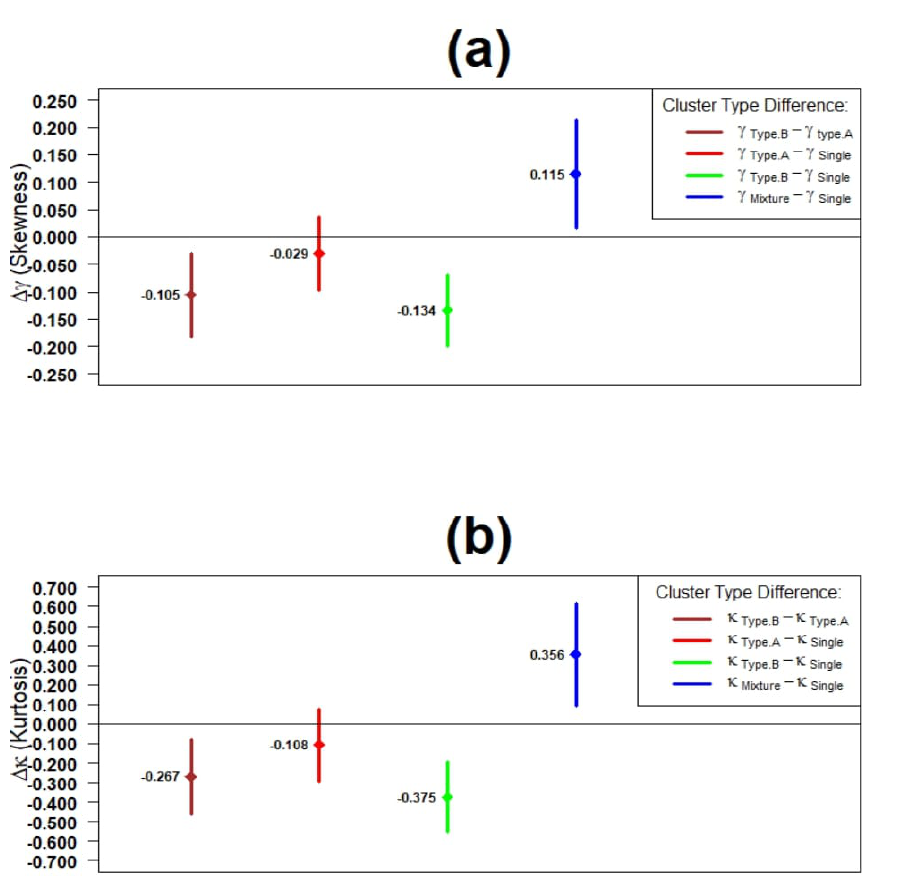
Figure 5. Plot of statistics difference of fitted IBPA ex-Gaussian SSRT random variable by cluster type ( n = 44): ( a ) skewness and ( b )